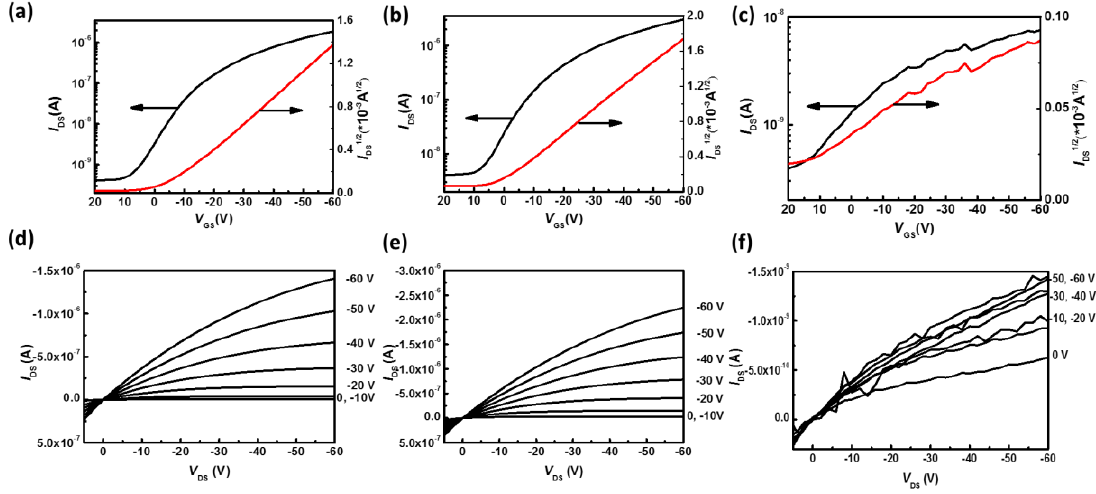
Table 1. Diameters and electrical properties of the devices prepared from three different solvent systems.